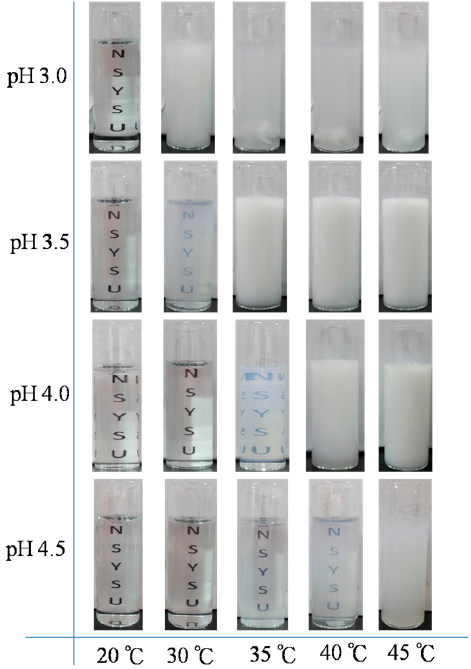
Figure 8. Photographs of the random copolymer PNIPAAm80- co -PAA20 in aqueous solutions at various temperatures and values of pH.